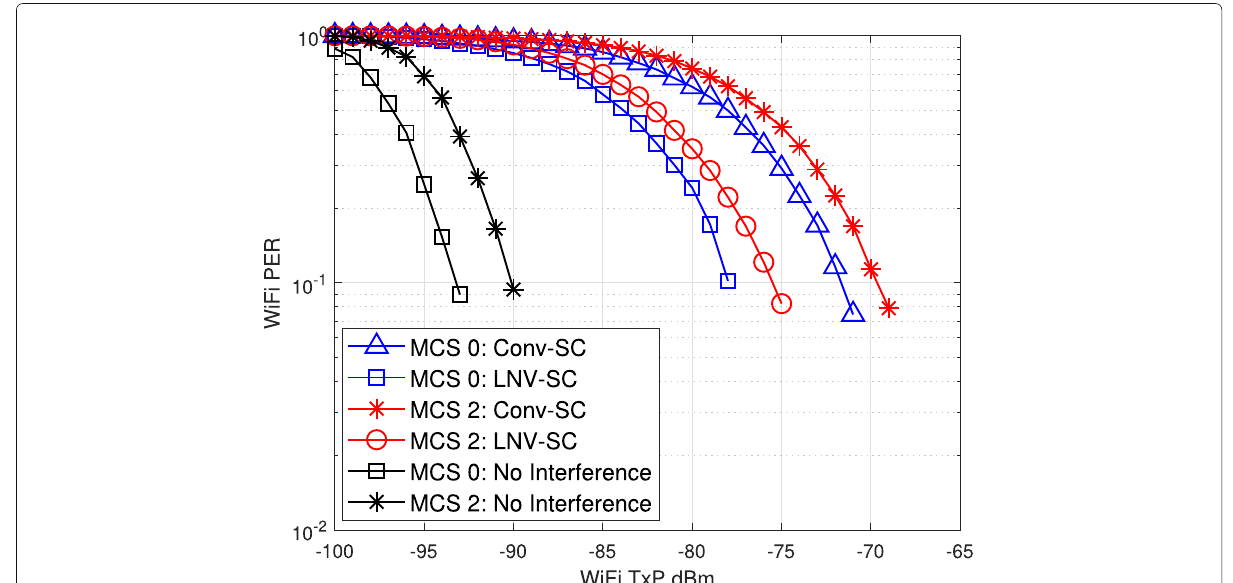
Fig. 10 LNV-SC vs Conv-SC for single-antenna WiFi receiver in the presence of single interferer. LNV-SC achieves more gain in SNR compared to Conv-SC for all the WiFi MCS